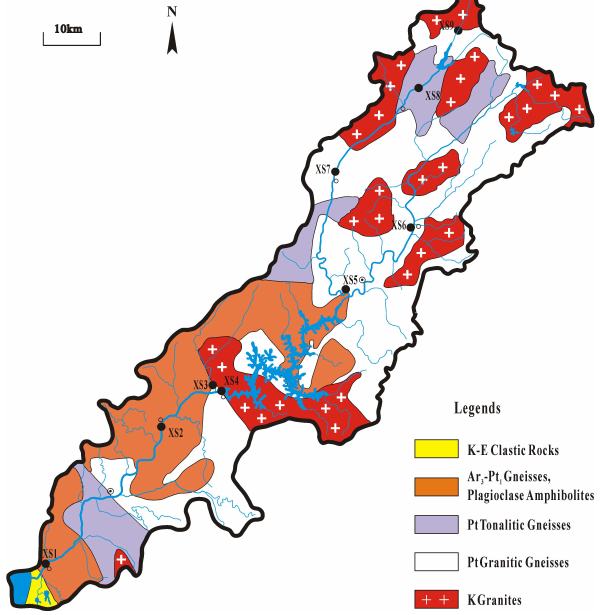
Fig. 2. Geological map of the Xishui River catchment (modified from the China Geological Survey, 2004).